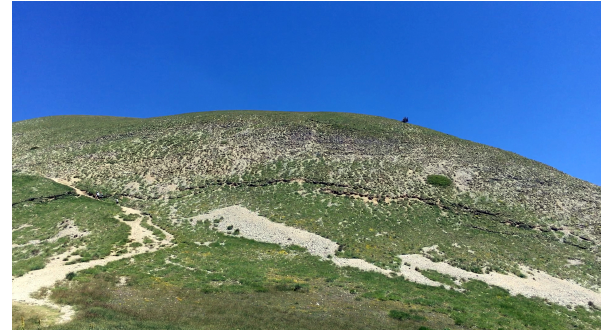
Figure 15. Some fractures (NNW–SSE) related to the 2016 earth- quake. They are about 40cm wide and located in the debris on the southern side of Mount Vettore.